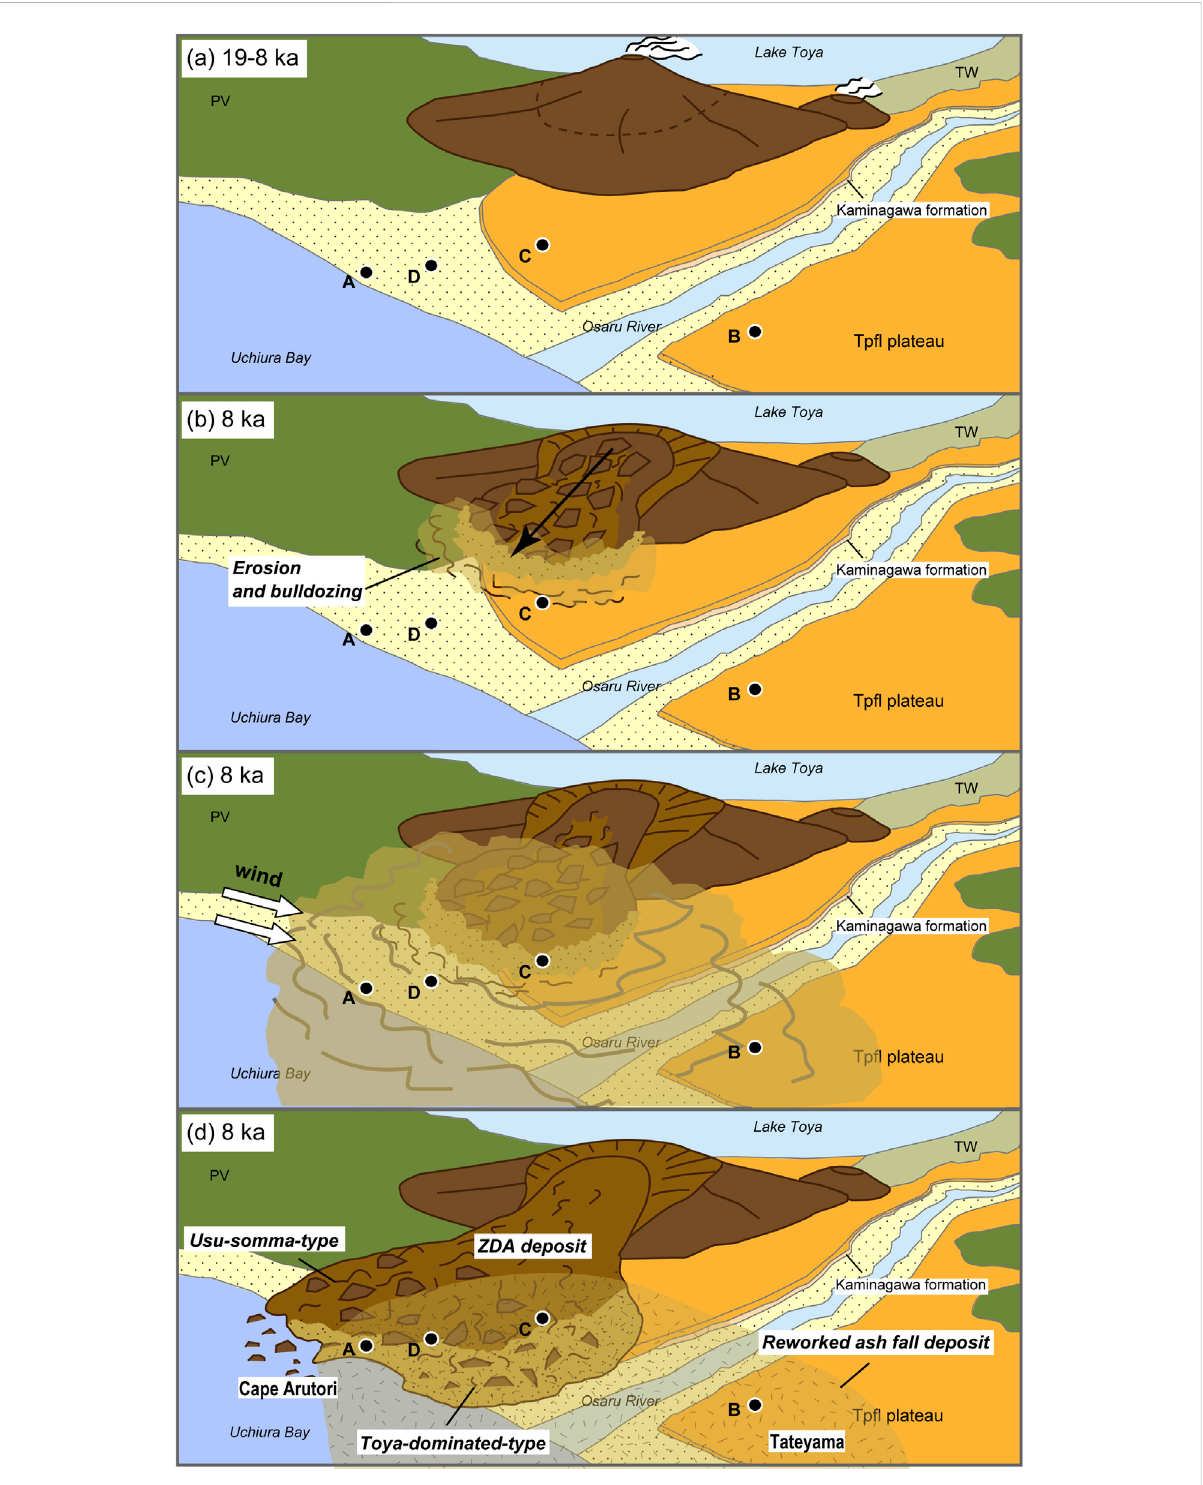
FIGURE 12 Cartoon showing the sequence of the Zenkoji collapse and ZDA generation and emplacement at 8 ka. (A) The edi fi ce of Usu volcano was constructed on a basement composed of Plio- and Pleistocene volcanic rocks in the western area, and Tp fl deposit in the eastern area. (B) The ZDA wasgeneratedbyasectorcollapseat8 ka.Densematerialsofthecollapsededi fi ceerodedtheunderlyingbedrockalongthe fl owpath,especiallythe Tp fl deposit and the ZDA bulldozed the basement material. The non-welded silicic Tp fl deposit was deformed and fragmented to form an ash cloud of silicic pyroclastic materials. (C) Deformation and fragmentation of the Tp fl deposit progressed to form a dense ash cloud, which was dispersed eastward due to prevailing westerly winds. However, the low temperature of the ash cloud prevented it from rising high and ash fall was restricted to proximal areas of the ZDA. (D) The ZDA emplaced Toya-dominated-type hummocks (see text) in the southeast area, where the diluted reworked ash settled (the Arutori ash), whereas the denser ash fall occurred east of ZDA deposit (the Tateyama